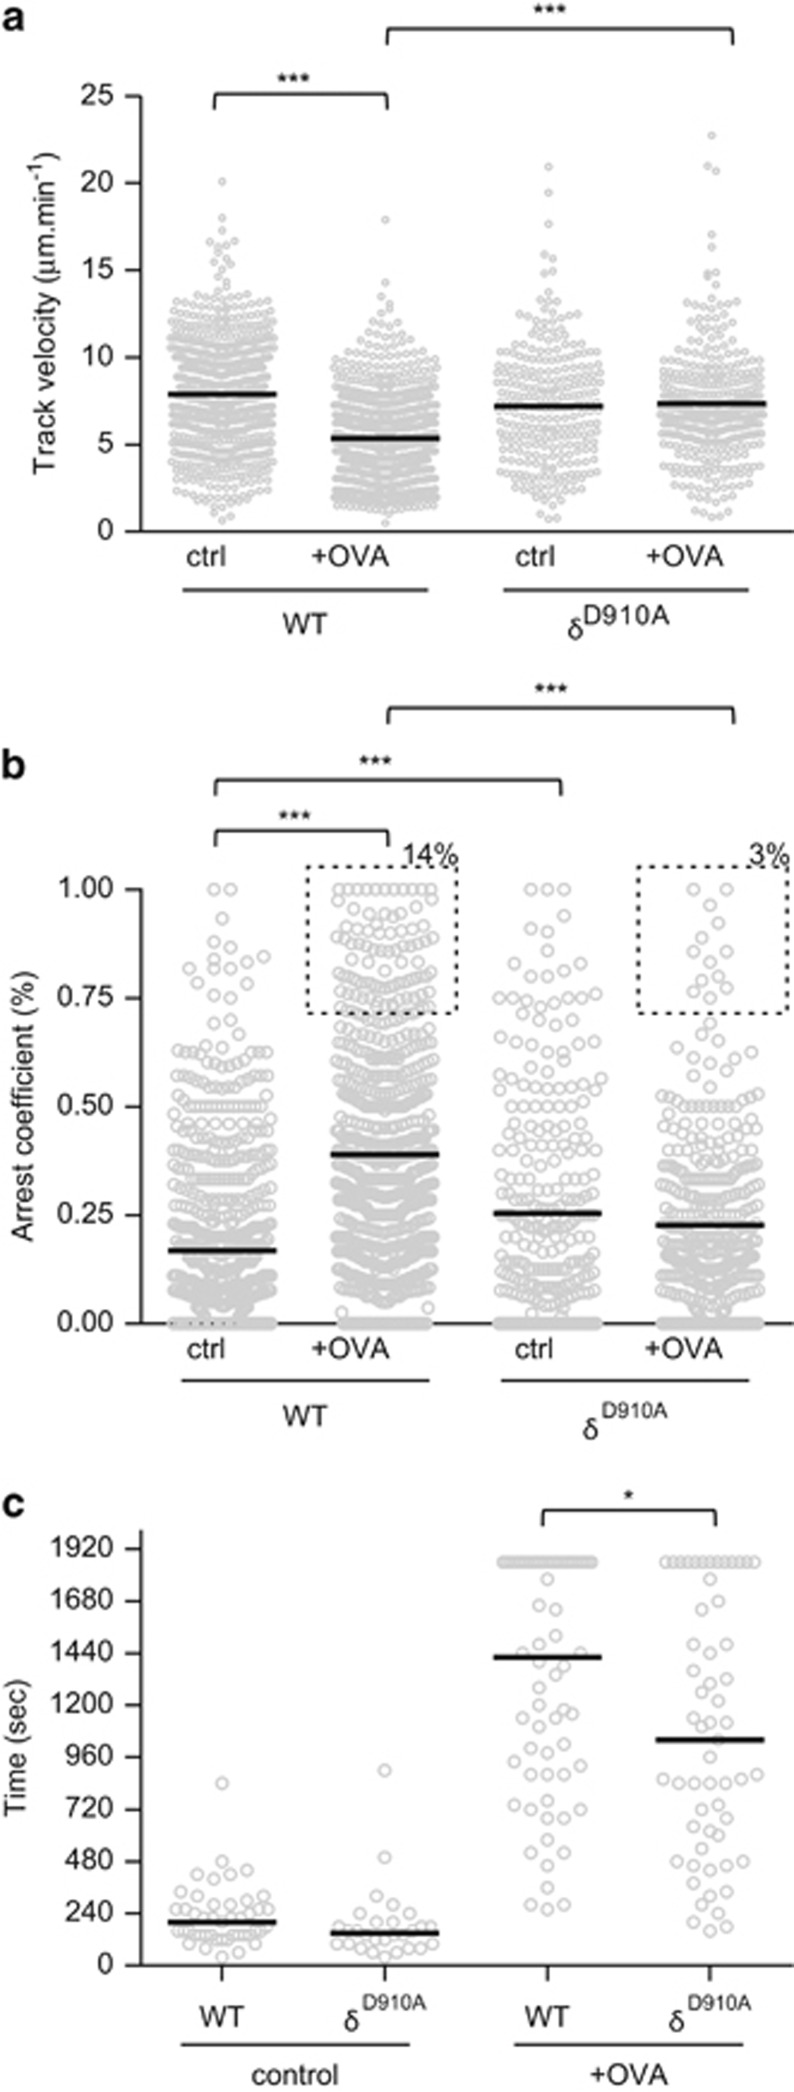
PI3Kδ is important for T-DC interactions in lymph node slices. CD4+ T-cell blasts labelled with CMFDA and RFP+ DCs were added to congenic lymph node slice in the presence or absence of OVA323-339 peptide. Mean velocity (a) and arrest coefficient (b) of WT and p110δD910A OT2 cells in presence or absence of peptide. Dashed boxed in (b) indicate the frequency of WT and p110δD910A OT2 cells with an arrest coefficient >0.7 (arrested). (c) Contact times between OT2 CD4+ T cells and DCs. (a–c) Data are representative of at least two independent experiments.